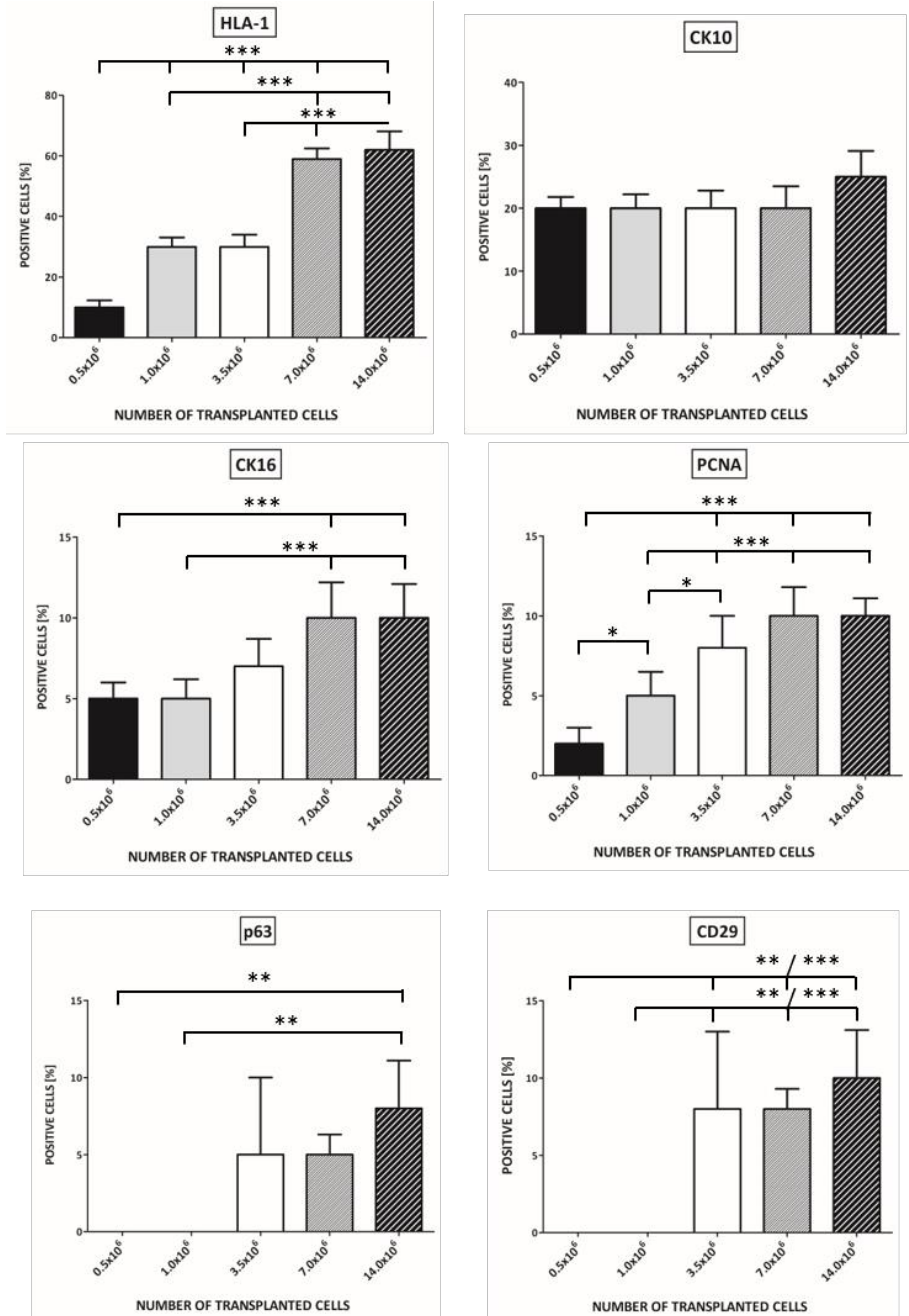
Figure 3. The percentage of keratinocytes in newly formed epidermis positive for HLA-1, CK10, CK16, PCNA, p63, and CD29 depending on the number of transplanted cells. The follow-up time was 21 days. Statistically significant results are shown at the bar graph (* p < 0.05, ** p < 0.01, *** p < 0.001). After the transplantation of 0.5 x10 6 keratinocytes, the expressions of both CK10 (F 4,20 = 2.78, p = 0.54) and CK16 (F 4,20 = 12, p < 0.0001) were detected in granular and spinous layer of newly formed epidermis (Figure